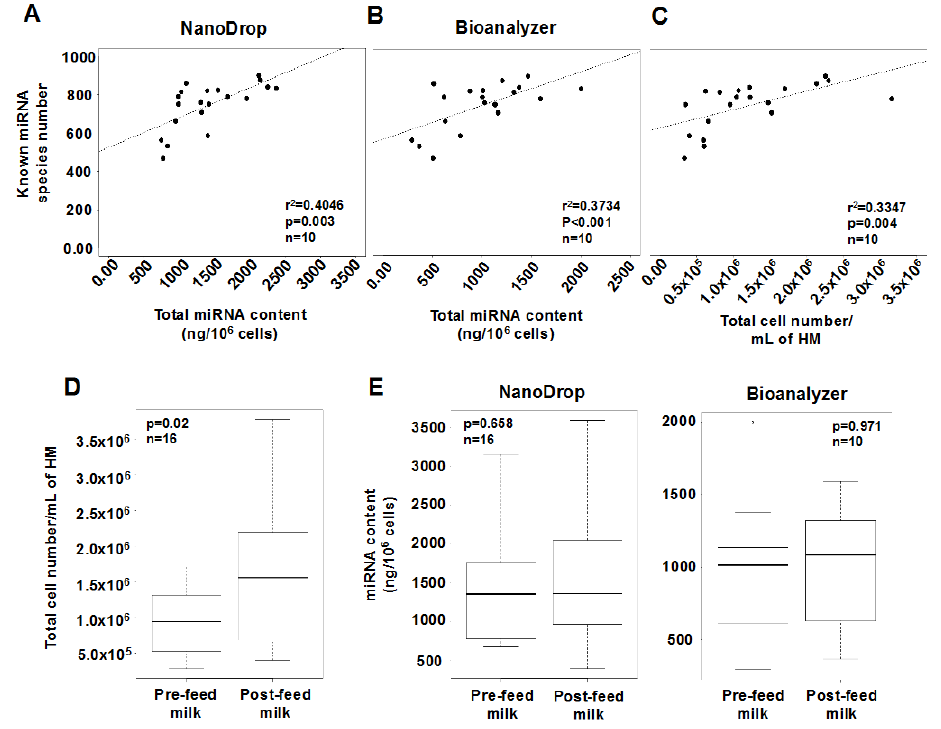
Figure 3. Cont . Figure 3. Cont .